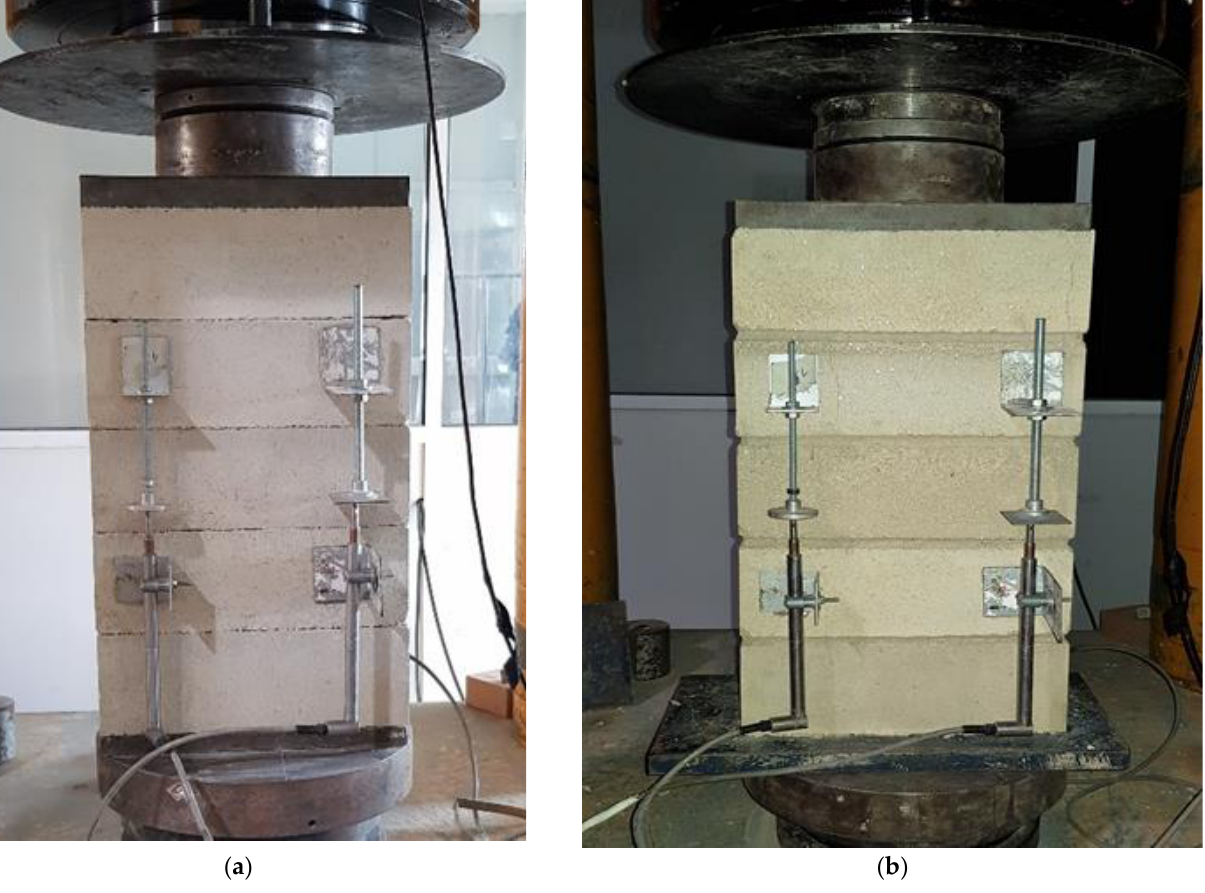
Figure 6. Setup of the compression tests conducted on masonry prisms: ( a ) DSP and ( b ) MP.